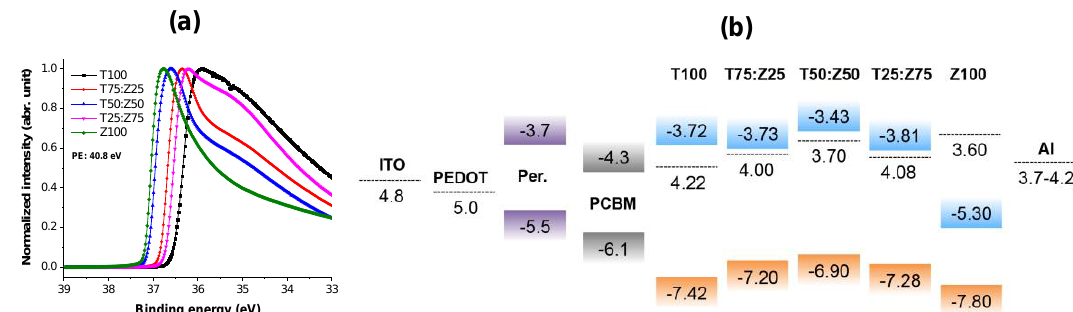
Figure 2. ( a ) UPS spectra and ( b ) proposed energy band diagram of TiO x :Zn 1−x Cd x S nanocomposite films. Energy levels of ITO, PEDOT:PSS, perovskite, PC 70 BM and Al were taken from other studies [3,32]. Photon energy (PE) is 40.8 eV.